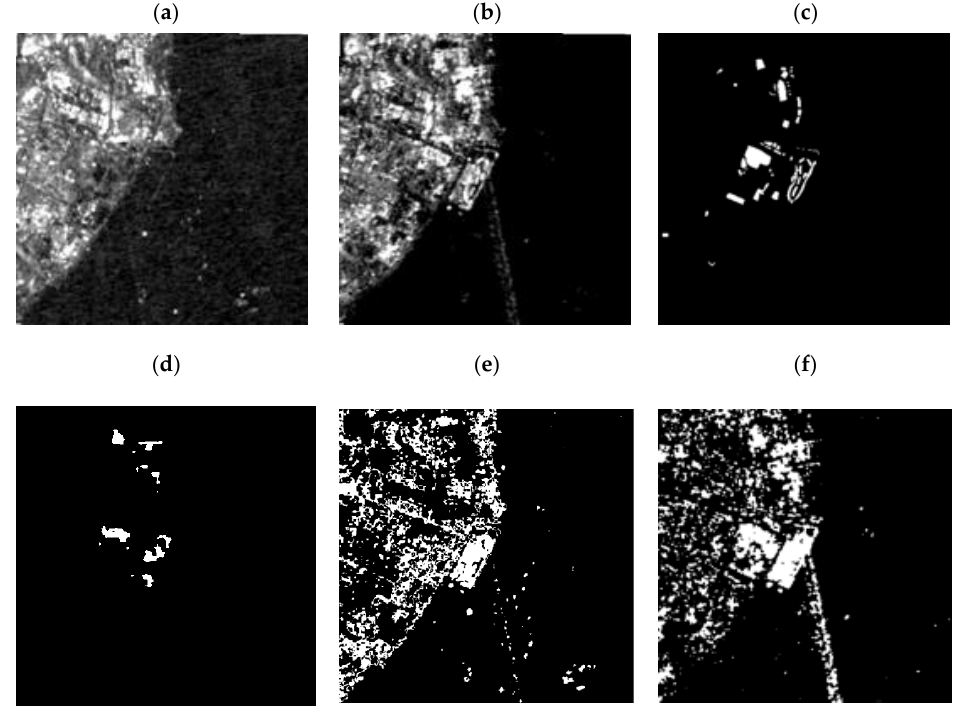
Figure 12. Result of the first Xiamen test site. The resolution of each image is 6 km × 6 km. ( a ) Time 1 SAR data, ( b ) Time 2 SAR data, ( c ) ground truth, ( d ) result of proposed model, ( e ) result of FCM, ( f ) result of Otsu thresholding.